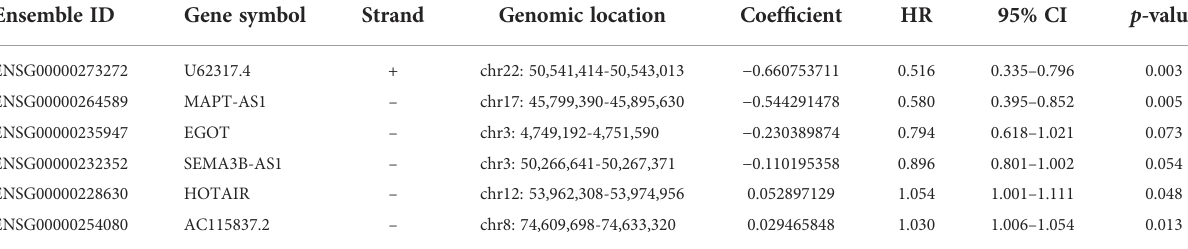
TABLE 2 The expression of the six lncRNAs generated from the multivariate Cox regression analysis.